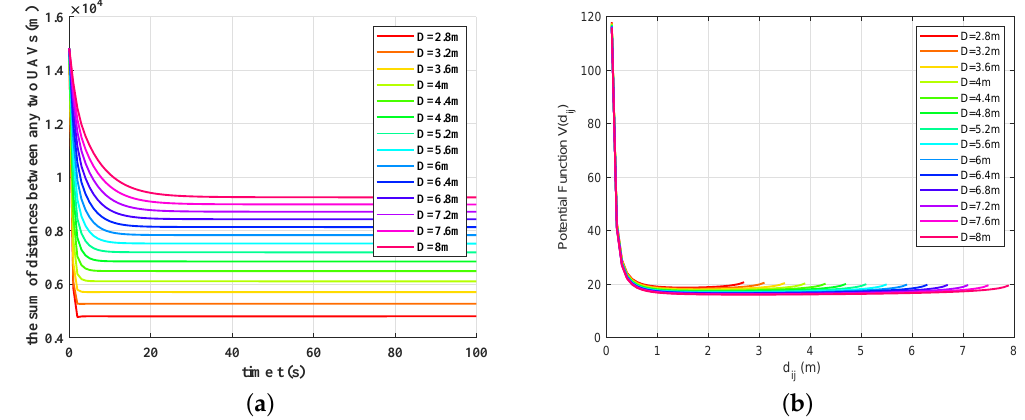
Figure 3. Energy costs of 80 UAVs versus time under different connected communication radii and relative specific functions. ( a ) energy costs; ( b ) specific functions.